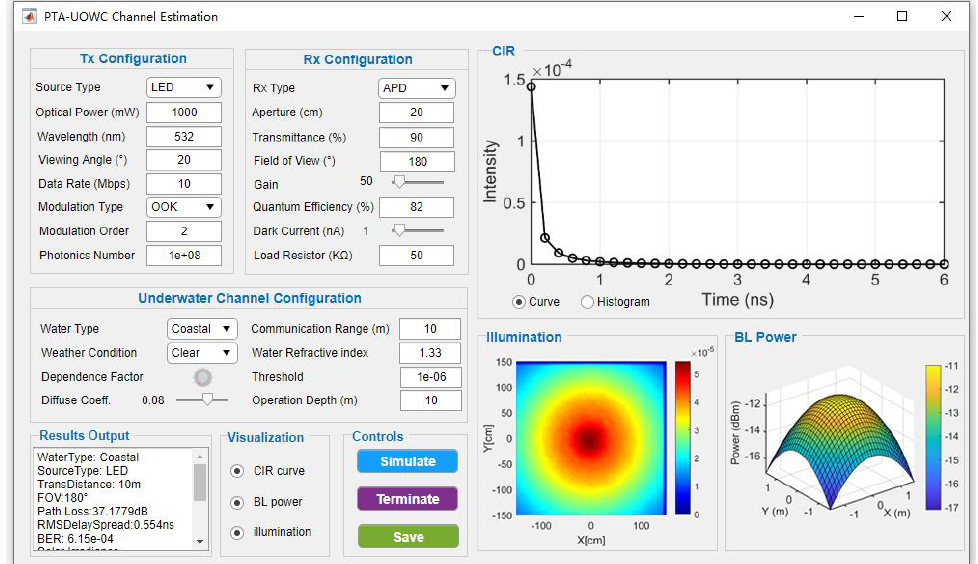
Figure 4. The graphical user interface of the PTA-UOWC simulation platform.